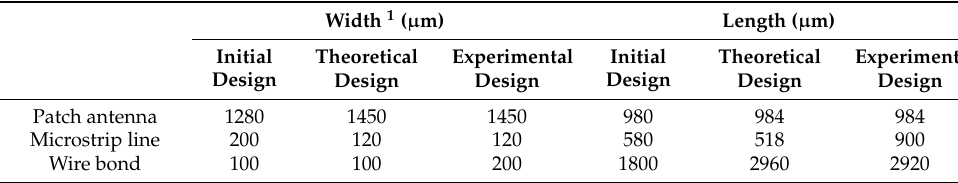
Figure 1. Wire-bonded patch antenna: ( a ) simulation model; ( b ) reflection coefficient and gain; ( c ) co-polarized and cross-polarized radiation patterns in xz -plane; ( d ) co-polarized radiation pattern in yz -plane (the cross-polarization pattern in yz -plane is not shown because its values are less than − 80 dBi) [43]. Table 2. Dimensions of the wire-bonded patch antenna.